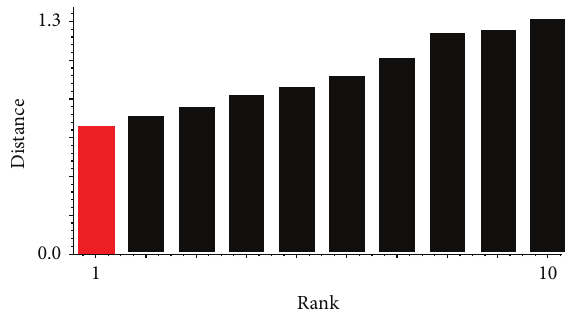
Figure 4: Representation of outlier calibration standards.